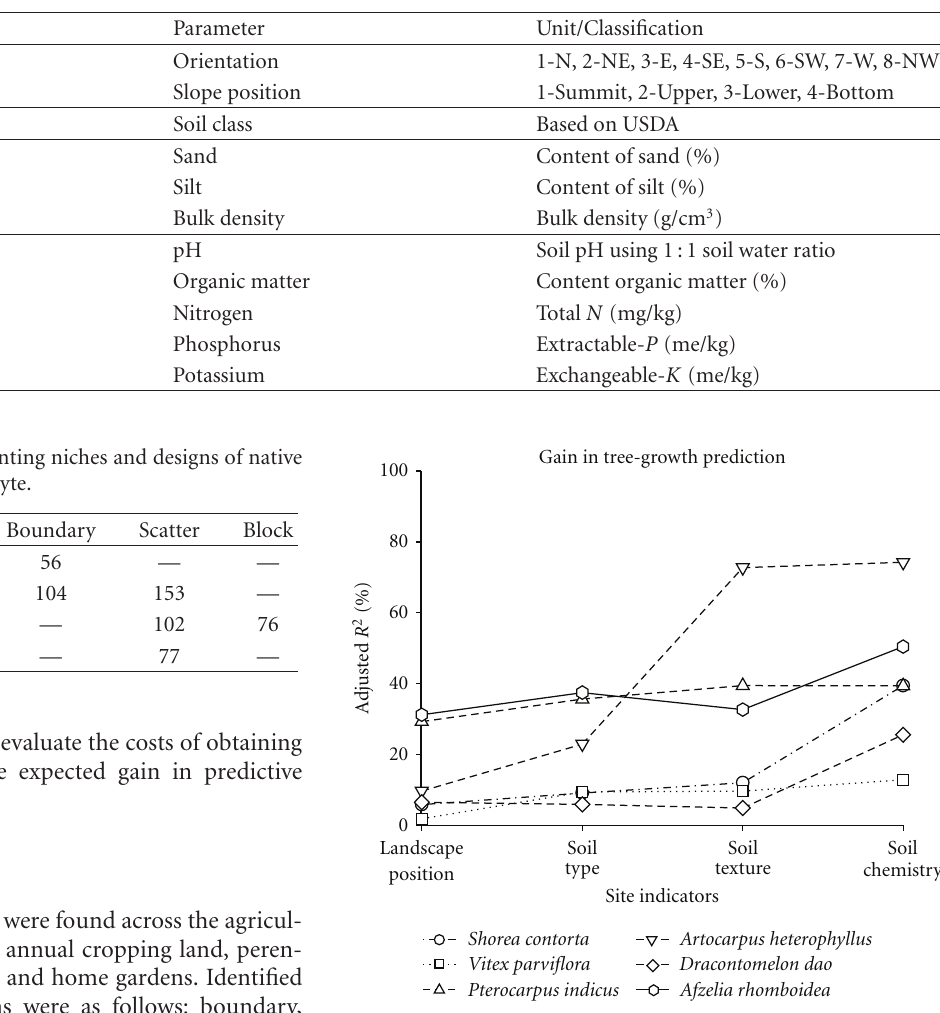
Table 3: Set of site quality indicators used in four (additive) steps of analysis.